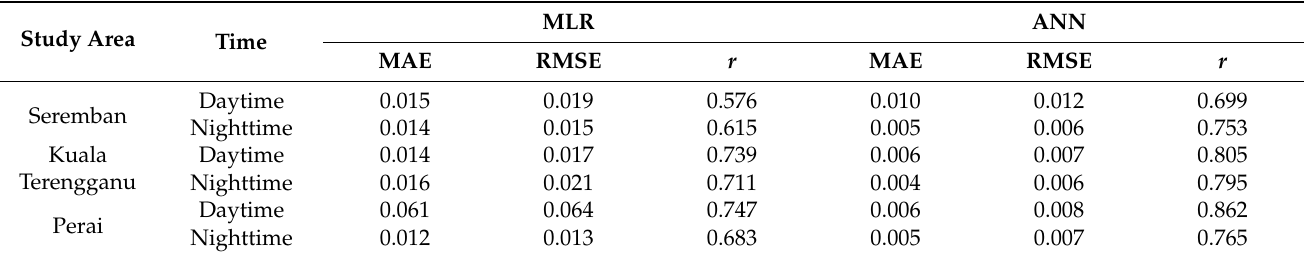
Table 6. Predictive Model